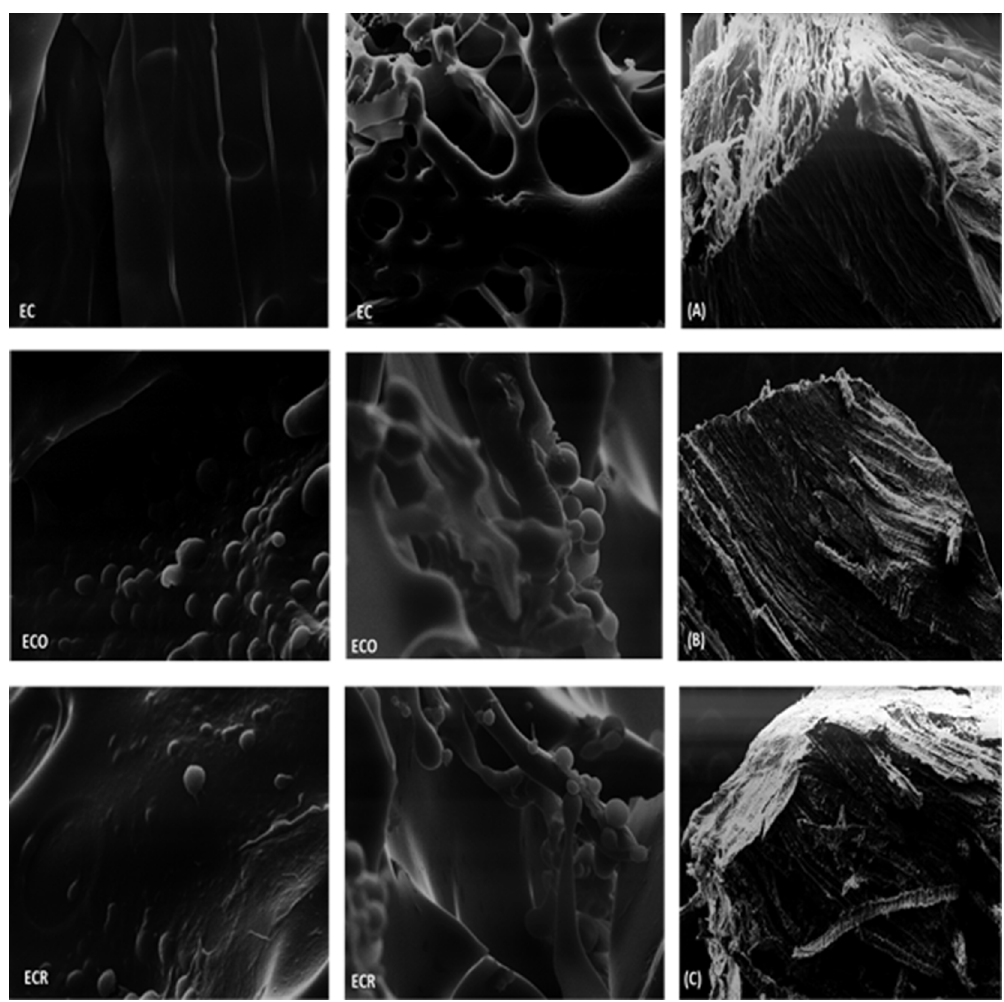
Fig 1. Scanning electron micrographs of the coating without oil (EC), with oregano essential oil (ECO), with rosemary essential oil (ECR), alginate coating (A) and meat with alginate coating (B and C). Magnification of 40x, 1200x, 1800x.